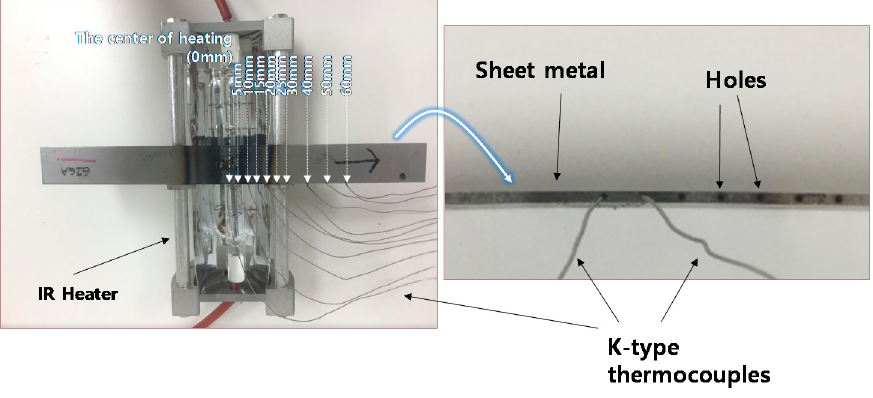
Figure 2. Local heating test.